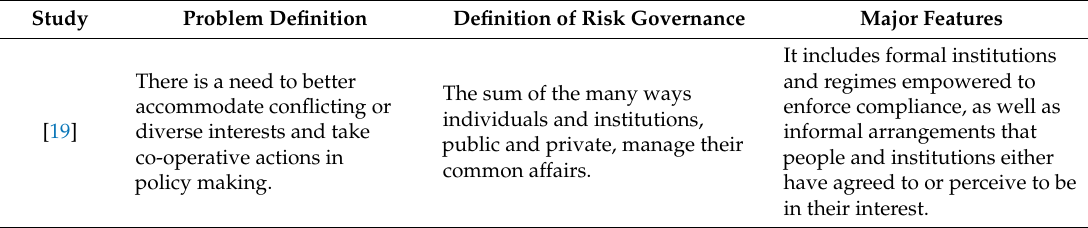
Table A1. (Selected) risk governance definitions and